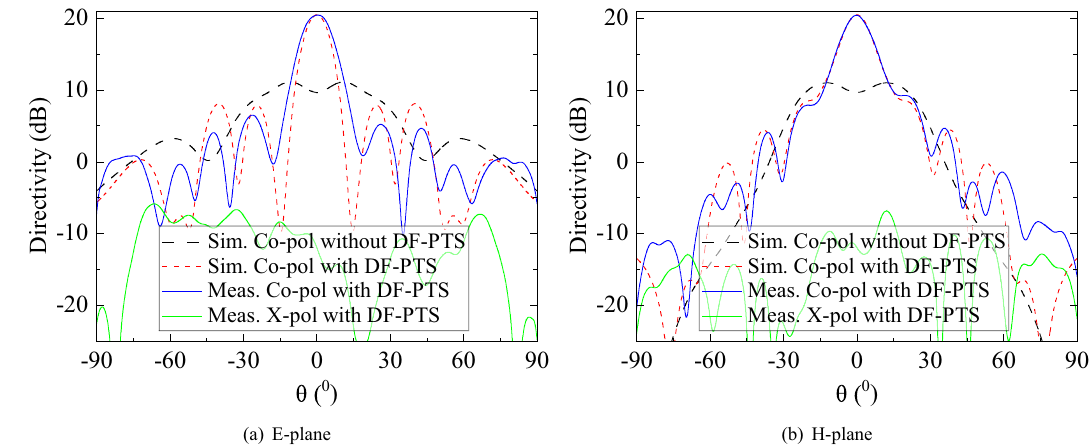
Figure 12. Measured and predicted far-field pattern cuts of the RCA with and without the DF-PTS, at 12.5 GHz.